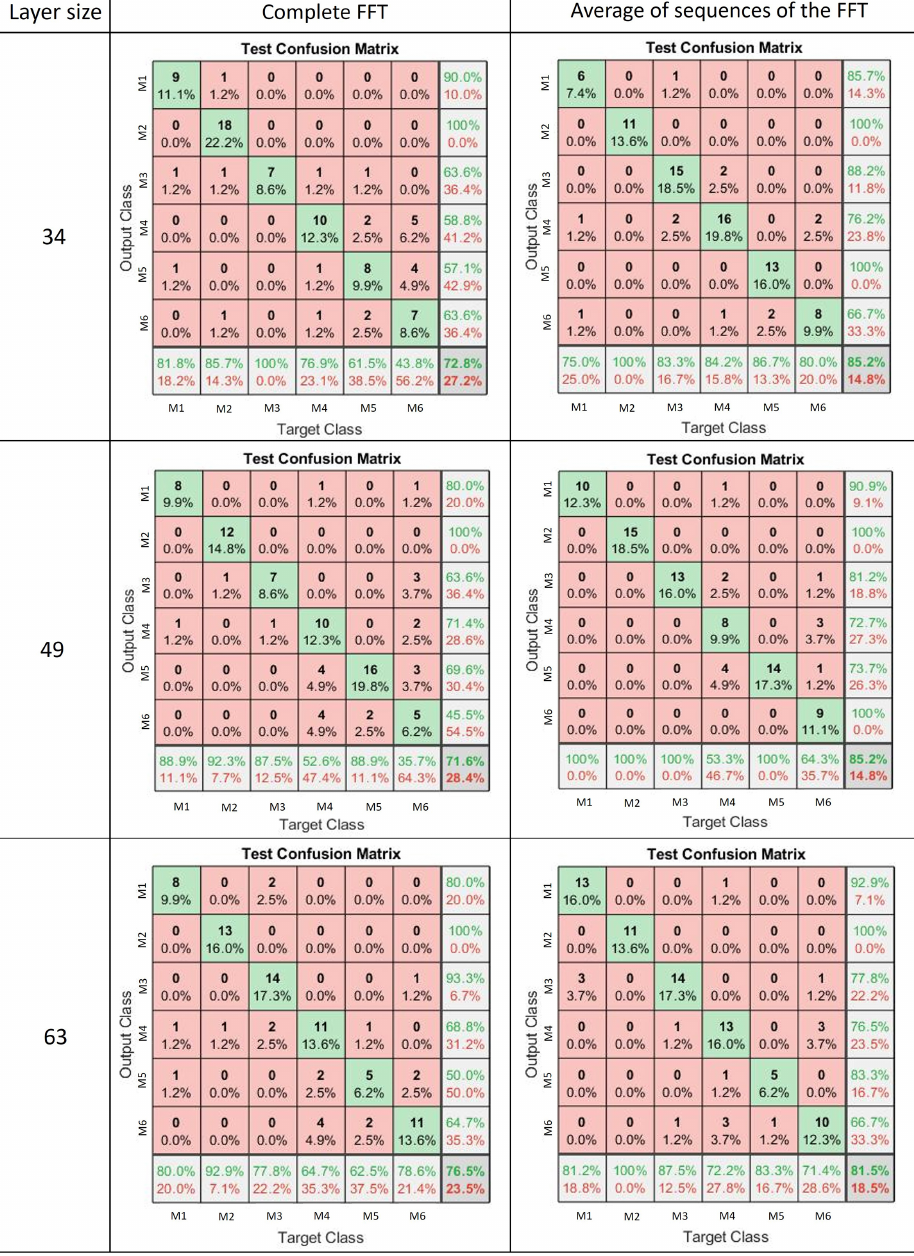
Figure 13. Results test for the